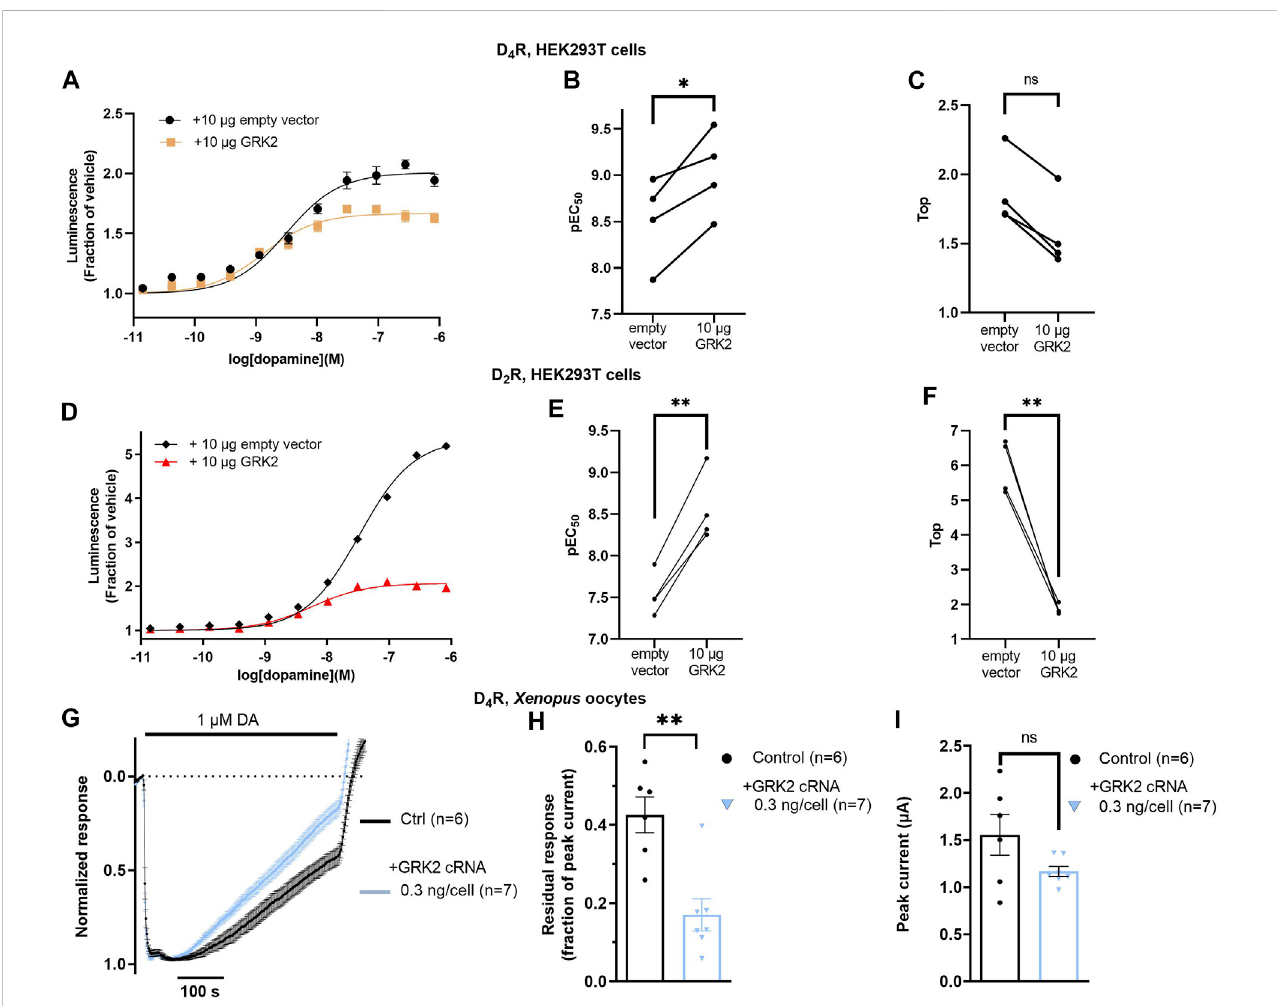
FIGURE 4 Impact of GRK2 co-expression on arrestin recruitment to the D 4 R and on desensitization of D 4 R-evoked GIRK responses. (A) Concentration- dependence of dopamine-induced luminescence increase in cells co-expressing LgBiT- β arr2 and D 4 R-NP, with and without exogenous GRK2 expression. Each data point represents mean ± SEM of data from eight replicate wells. Curves shown from one representative experimentout of atotal of four.Data from all experiments are shown in (B, C) . (B) Co-transfection of 10 µg of GRK2 signi fi cantly decreased the dopamine EC 50 in the β arr2 recruitment assay by about 3-fold. *; p = 0.026, Student ’ s paired t -test. (C) Co-transfection of 10 µg of GRK2 did not signi fi cantly affect the Top parameter. ns; not signi fi cant, p = 0.125, Wilcoxon matched-pairs signed rank test. (D) Concentration-dependence of dopamine-induced luminescence increase in cells co-expressing LgBiT- β arr2 and D 2 R-NP, with and without exogenous GRK2 expression. Each data point represents mean ± SEM of data from eight replicate wells. Curves shown from one representative experiment out of a total of four. Data from all experiments are shown in (E, F) . (E) Co-transfection of 10 µg of GRK2 signi fi cantly decreased the dopamine EC 50 in the β arr2 recruitment assay by about 10-fold. **; p = 0.002, Student ’ s paired t -test. (F) Co-transfection of 10 µg of GRK2 signi fi cantly decreased the Top parameter. **; p = 0.003, Student ’ s paired t -test. (G) Peak-normalized and averaged traces of GIRK currents evoked